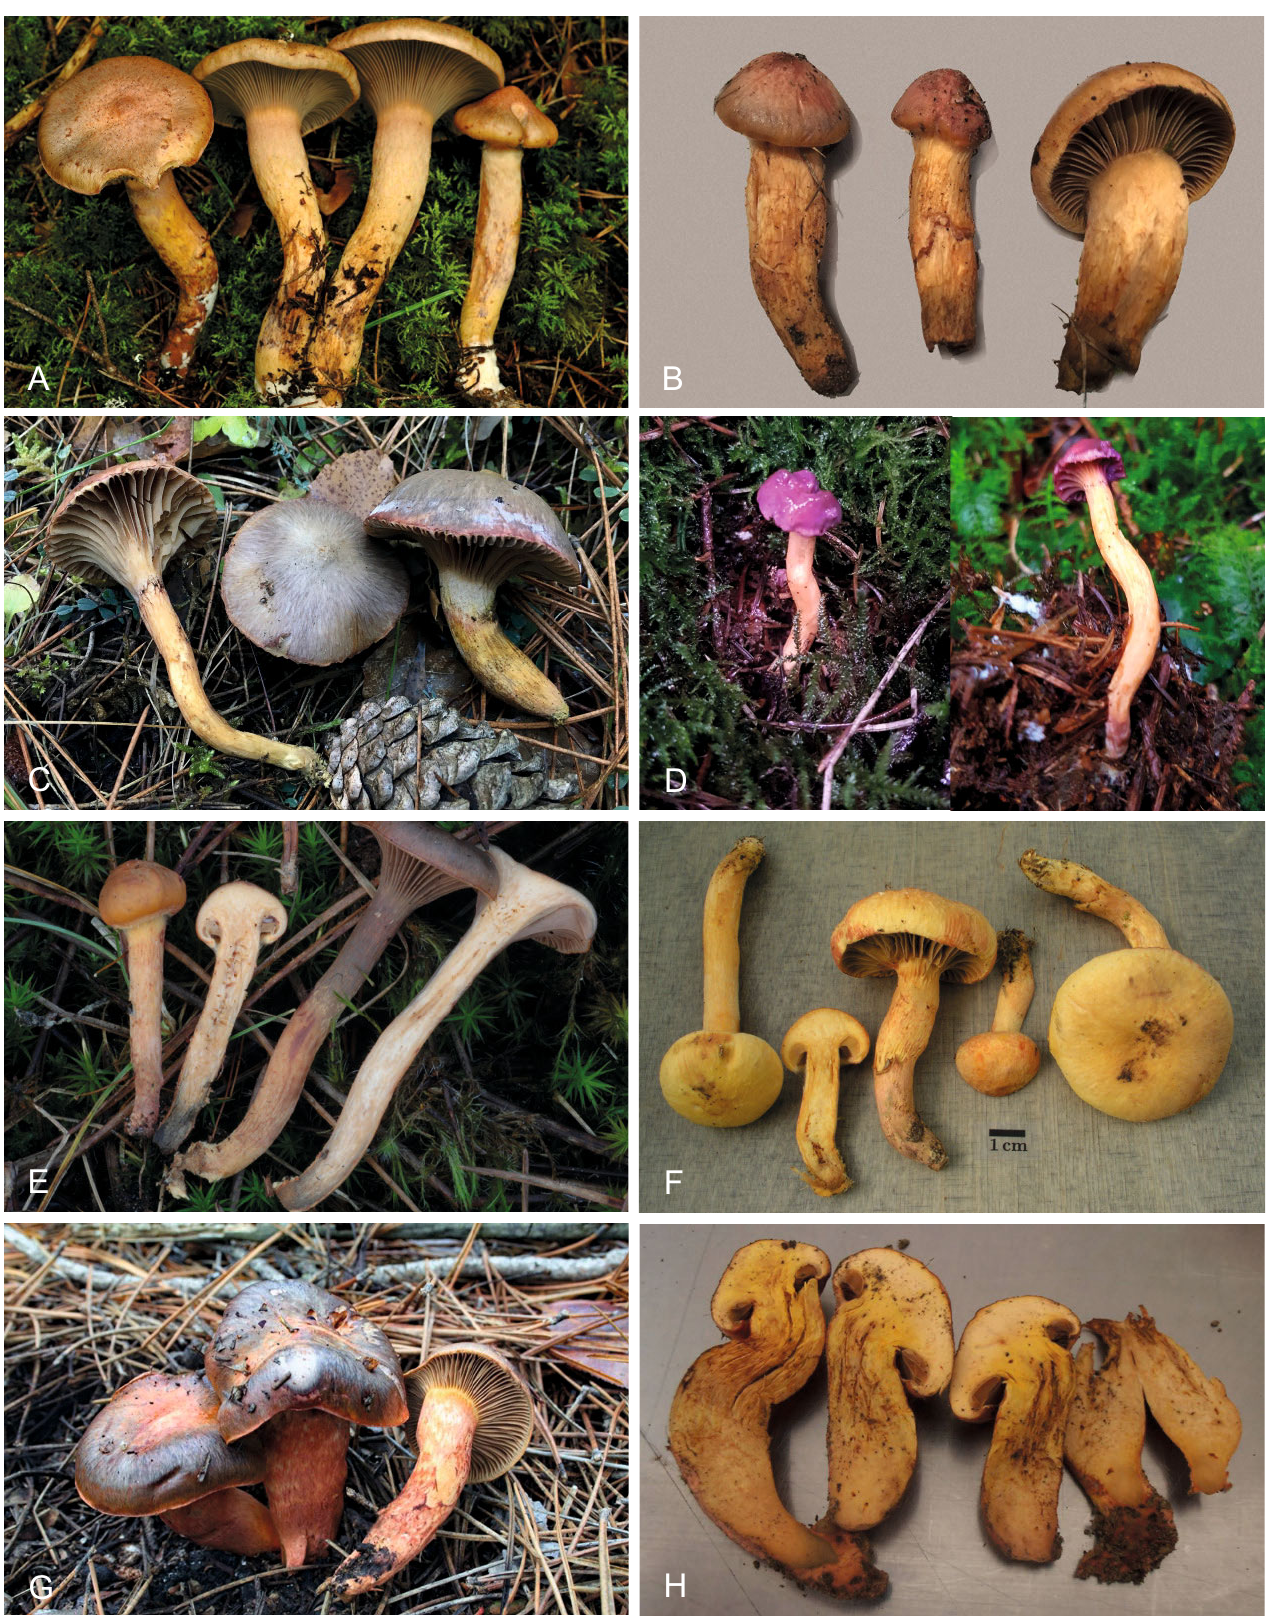
(K(M)237593). D. Atypical C. mediterraneus (K(M)237779). E. C. fulmineus (LIP 0401320). F. C . cf. helveticus (H7019100). G. C. subfulmineus (LIP 0401318, holotype). H. C. subfulmineus (LIP 0401323, showing colour of the trama). Not to scale; bar applies to F only. Photographs: A, Vello Liiv; B, and C, Geoffrey Kibby; D, Mel Oxford; E, Pierre-Arthur Moreau; F, Kare Liimatainen; and G and H, Michael